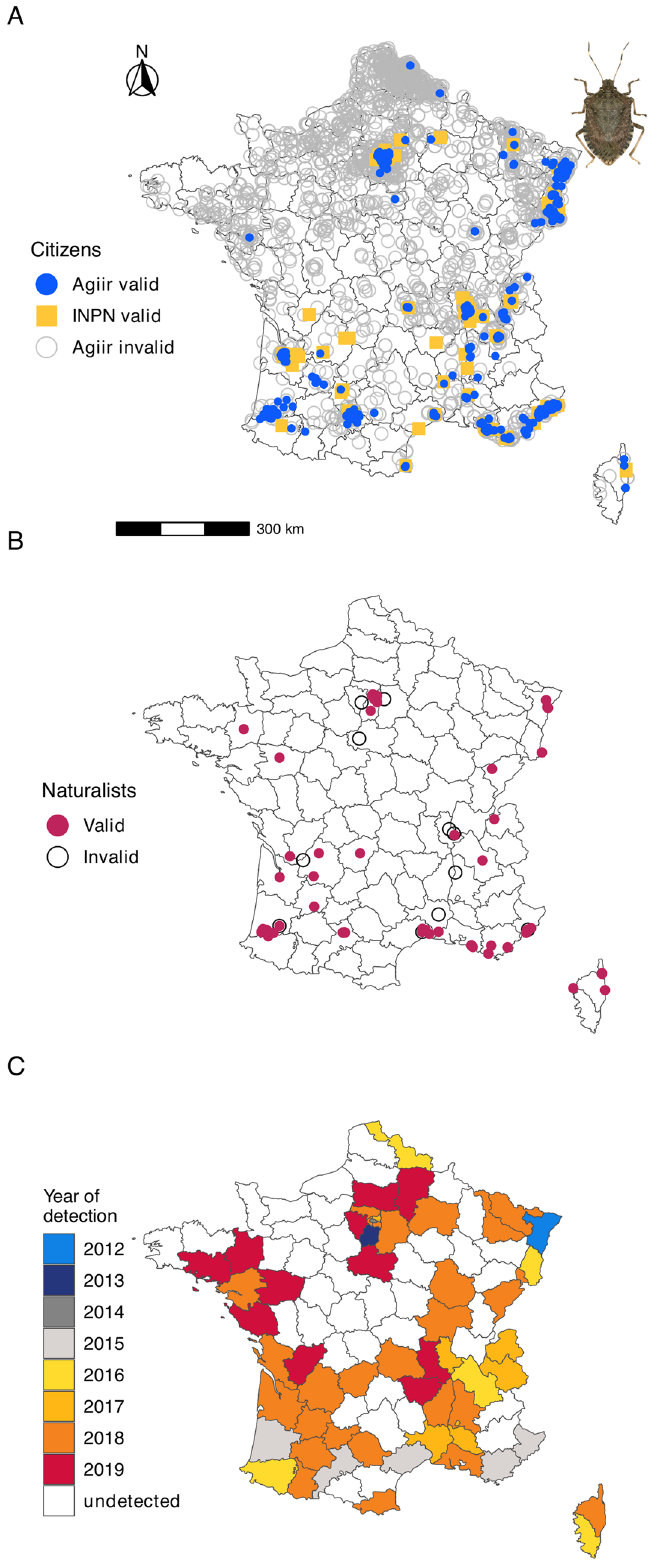
Figure 1. Occurrence data for Halyomorpha halys in France according to citizen sources. ( A ) Distribution of citizen contribution according to the French networks Agiir (Inrae) and INPN-Espèces (MNHN). ( B ) Distribution of sightings from naturalist sources. ( C ) Geographical expansion of the BMSB in France from 2012 to 2019 according to available data including GBIF sources. Photograph by J.C. Streito/Inrae. The maps were generated using R 4.0.3 (https:// cran.r- proje ct.